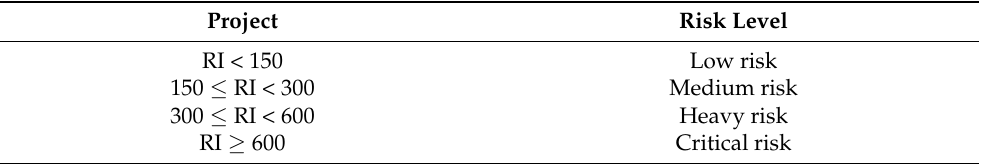
Table 3. Grading standards of potential ecological risk